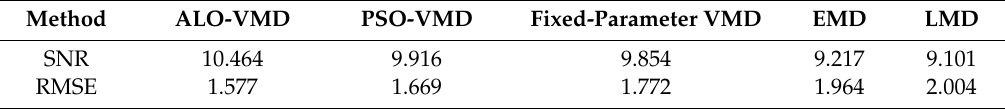
Table 5. The e ffi cient weighted kurtosis (EWK) value of each